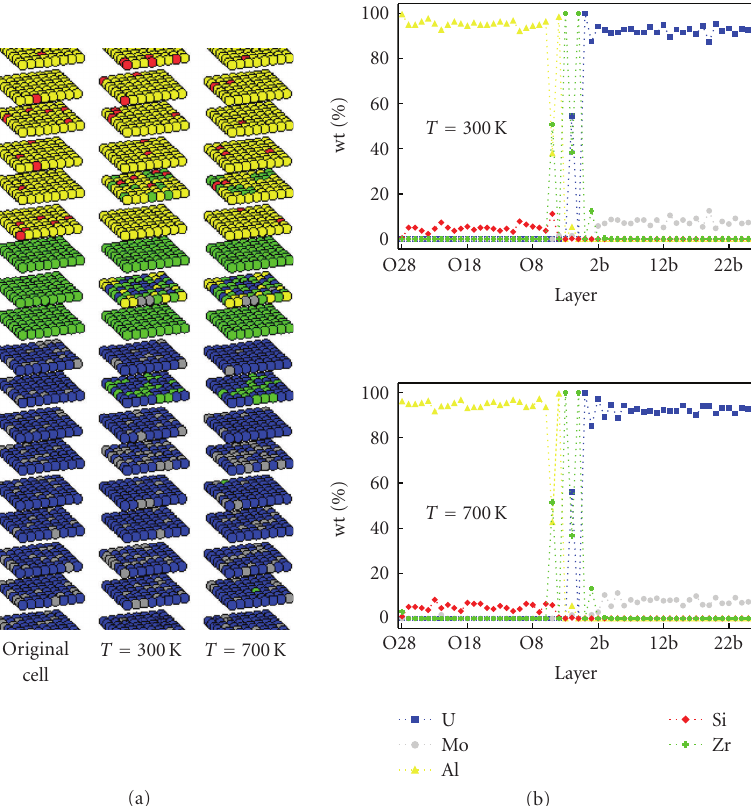
Figure 15: Intermediate states of a simulation of a computational cell with three C planes in the Al-5wt% Si/U-7wt% Mo interface. U, Mo, Al, Si, and C atoms (and profiles) are denoted in blue, grey, yellow, red, and green, respectively. The original location of the interface (at the onset of the simulation) corresponds to the label